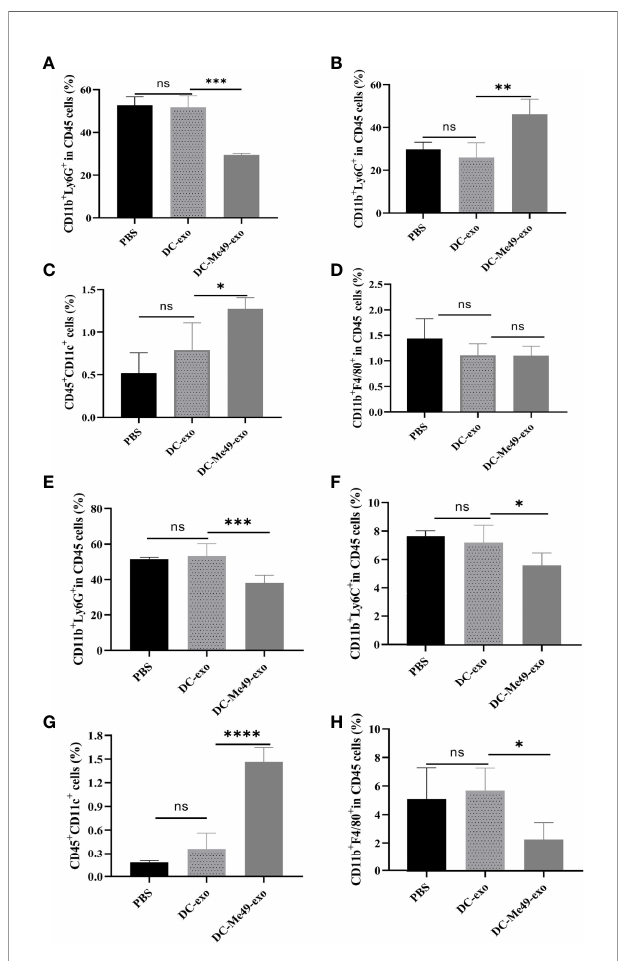
FIGURE 4 | DC-Me49-exo decreased the proportion of MDSCs in a mouse model of CRC. FCM analysis of G-MDSCs (anti-CD11b-APC, anti-Ly6G-PE) (A) , M-MDSCs (anti-CD11b-APC, anti-Ly6C-APC-700) (B) , DCs (anti-CD45- FITC, anti-CD11c-PC5.5) (C) and macrophages (anti-CD11b-APC, anti-F4/ 80-PB450) (D) in the blood of tumor-bearing mice treated with DC-exo, DC- Me49-exo and PBS. FCM analysis of G-MDSCs (E) , M-MDSCs (F) , DCs (G) and macrophages (H) in the tumor tissues of tumor-bearing mice treated with DC-exo, DC-Me49-exo and PBS. ns, ( p ≥ 0.05), * p < 0.05, ** p < 0.01, *** p < 0.001, **** p <